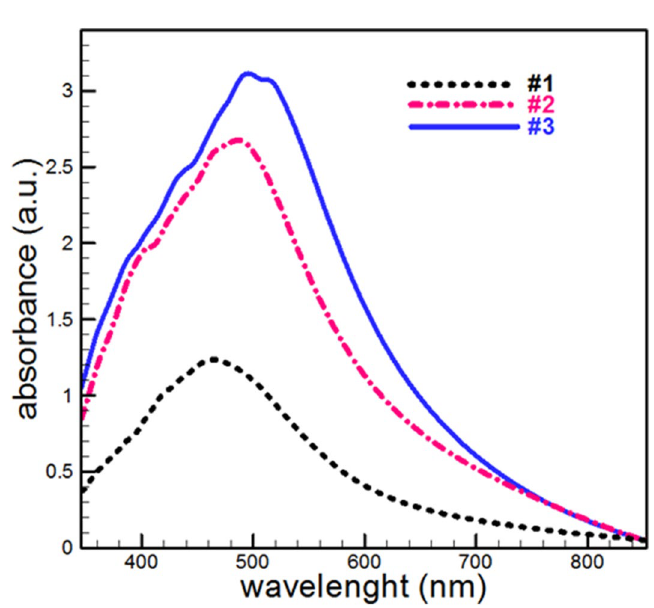
Figure 2. Absorption spectrum of fabricated samples.